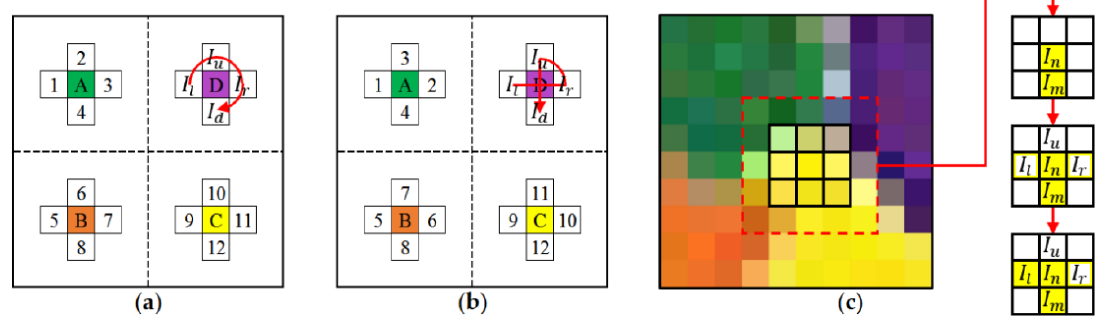
Figure 3. Elimination of Inspection Redundancy (EIR)-based inspecting and labeling processes of SNIC. ( a ) Inspection in clockwise rotation; ( b ) inspection in cross; ( c ) local inspecting process in a homogeneous region by EIR. Elements with the yellow box indicates that they are similar in color and satisfy Equation (4).